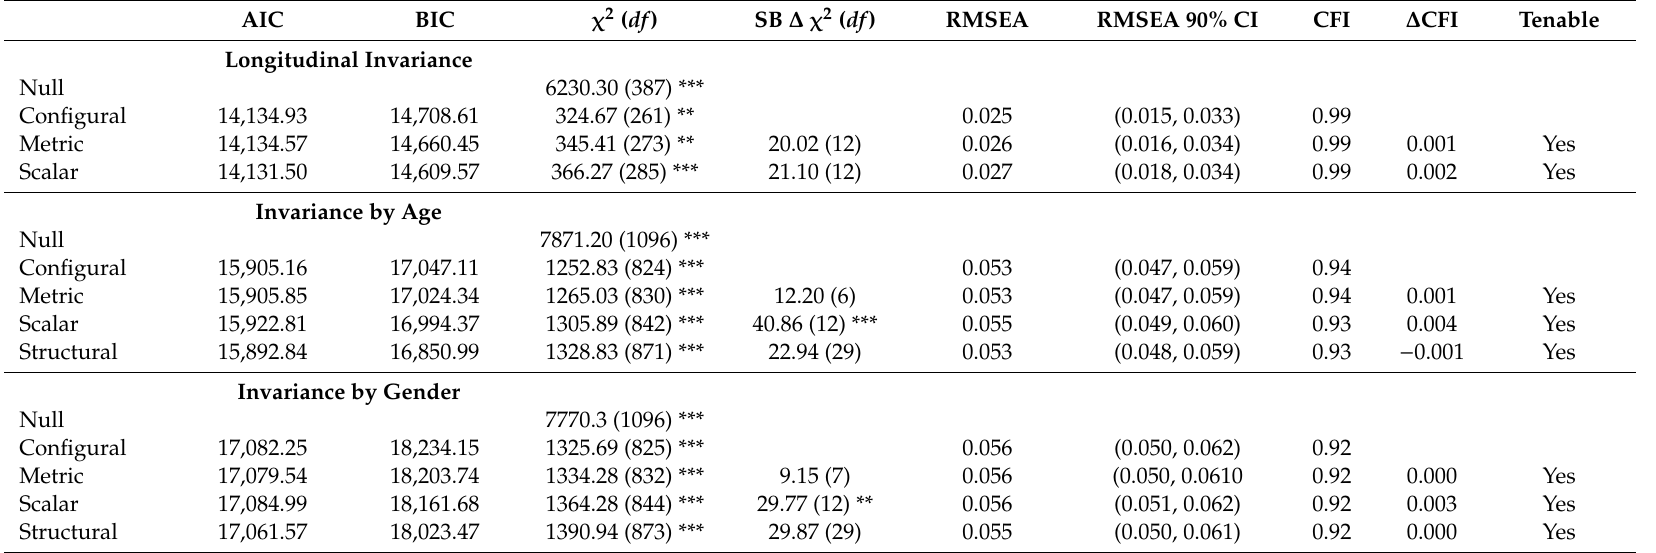
Table 2. Invariance